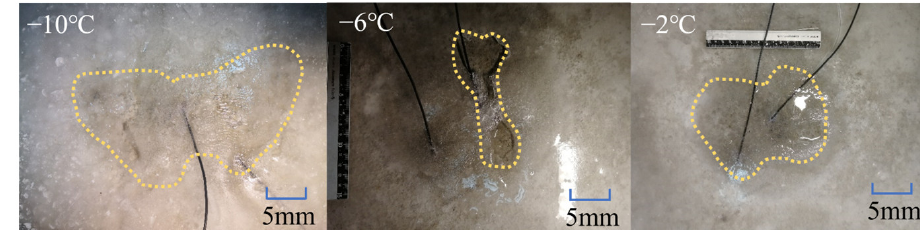
Figure 11. The actual deicing effect of each specimen at different initial temperatures.